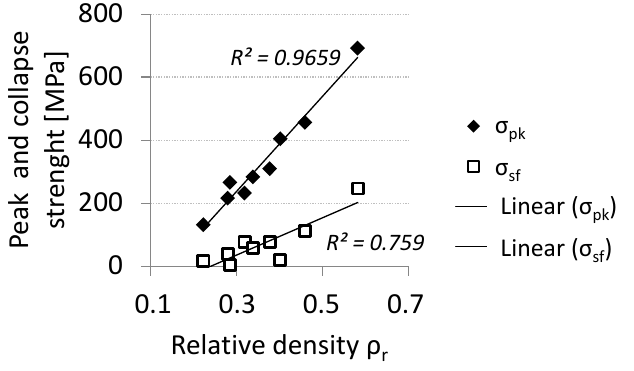
Figure 6. Peak and collapse compressive strength vs. relative